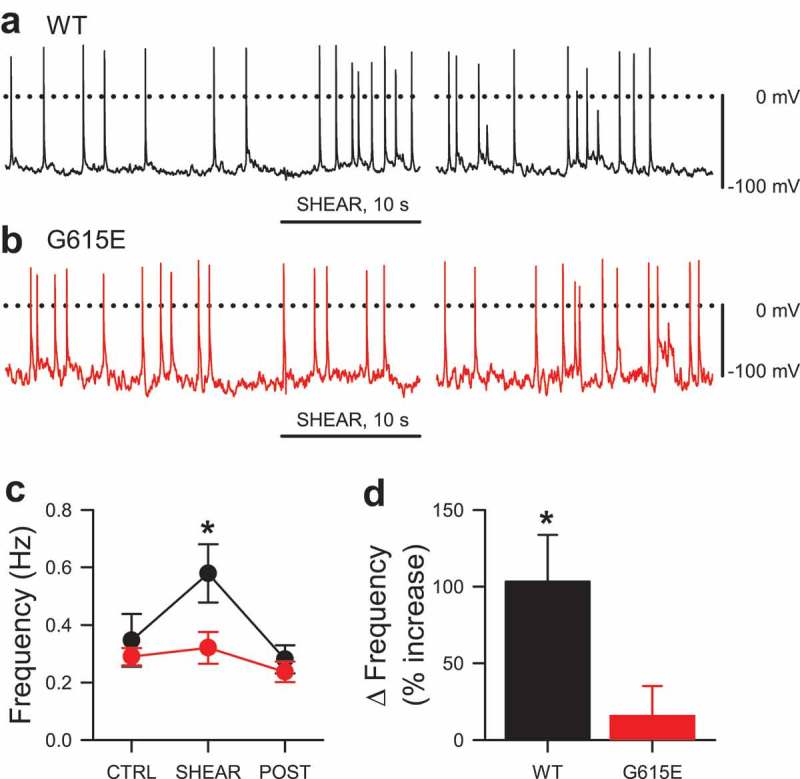
Mechanosensitivity of WT and G615E NaV1.5-induced spontaneous electrical excitability. (a-b), Gap-free current clamp recording of spontaneous potentials from an HEK293 cell expressing WT NaV1.5 (a) or G615E (b), before, during (underline), or 35 s after shear stress. (c), Average frequencies of spontaneous potentials from HEK293 cells expressing WT (black) or G615E (red) NaV1.5 channels, before (CTRL), during (SHEAR), or after (POST) shear stress (n = 6 cells each, *P < 0.05 vs. CTRL and P < 0.05 effect of genotype or shear by a two-way ANOVA with Dunnett post-test). (d), Average change in frequency of spontaneous potentials in HEK293 cells expressing WT (black) or G615E (red) NaV1.5 channels (n = 6 cells each, *P < 0.05 WT to 0% by a two-tailed one-sample t-test, NS for G615E).